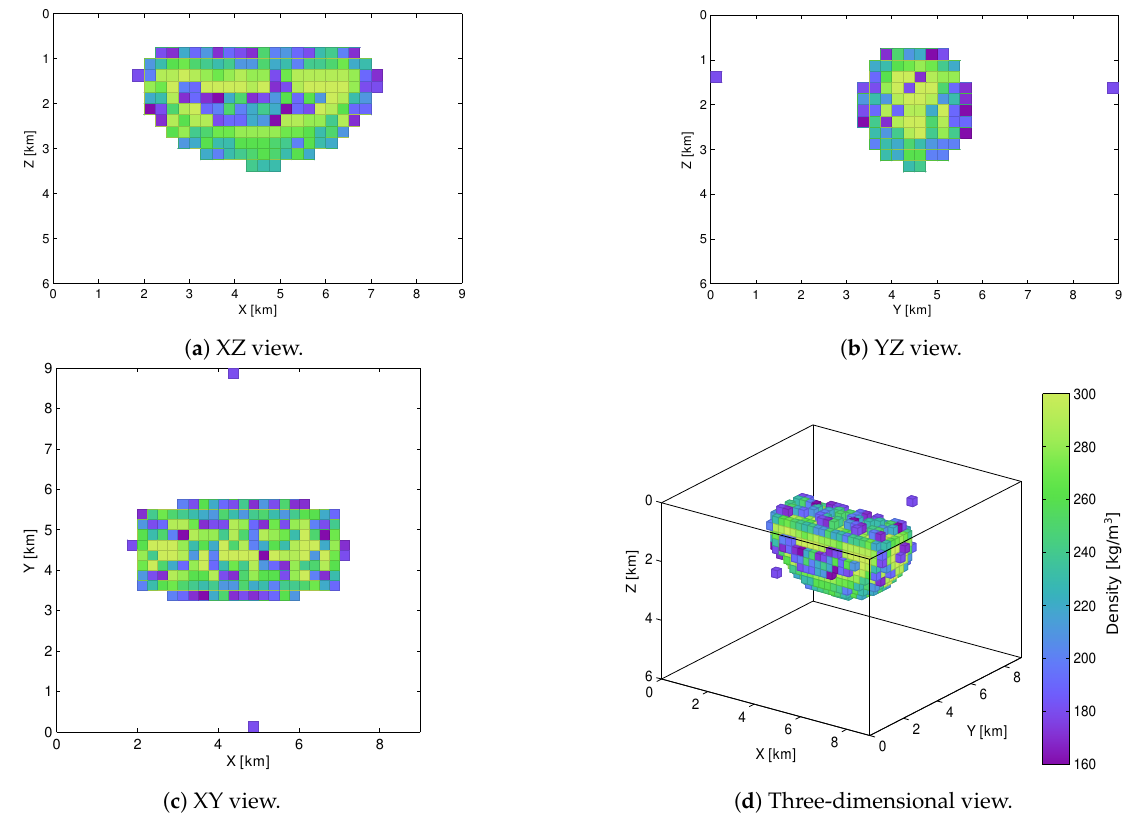
Figure 14. Inverted gravimetric T model.